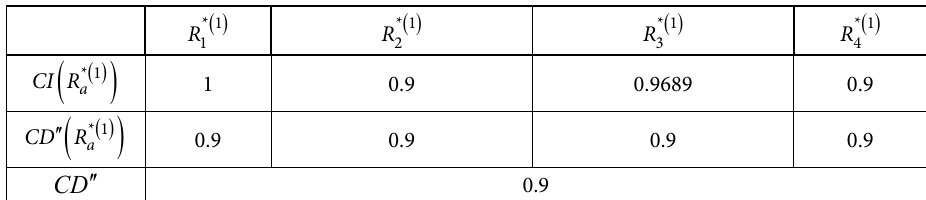
Table 4. The consistency indices and consensus degrees of all the optimal adjusted DHLPRs ( )